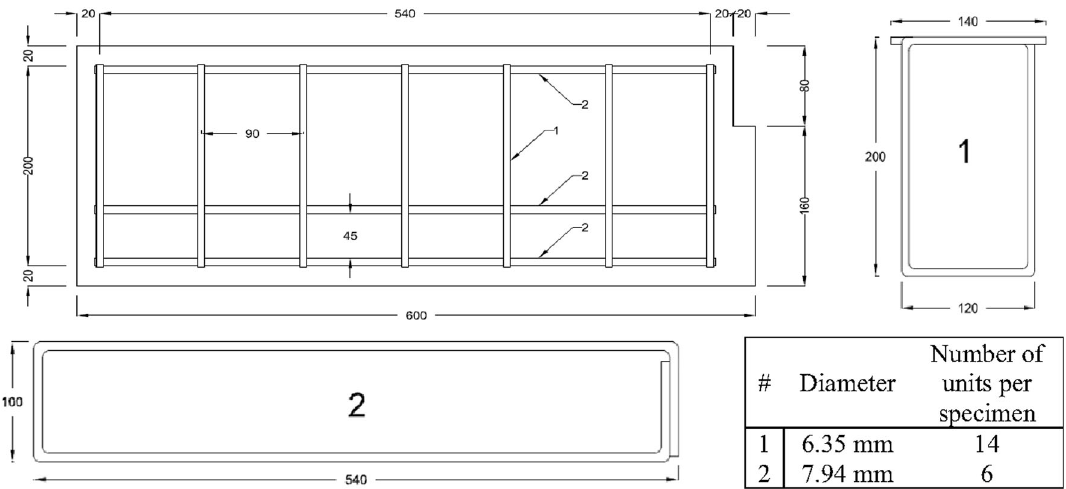
Fig. 3 Auxiliary reinforcement for Type B specimen (dimensions in mm).